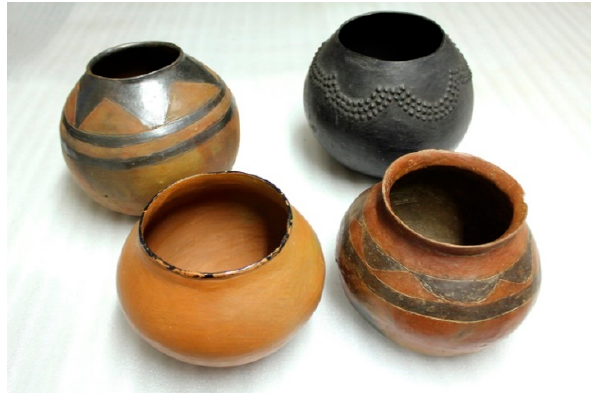
Figure 2. Ukhamba— a traditional beer-drinking vessel. Figure 2. Ukhamba —a traditional beer-drinking vessel.